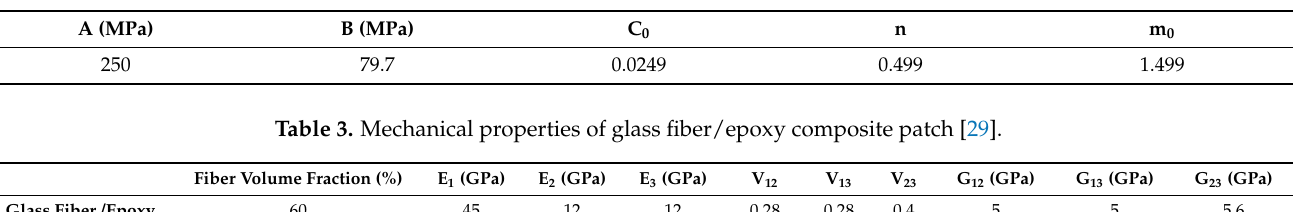
Table 2. The Johnson–Cook model constants for Al6061-T6 [28].